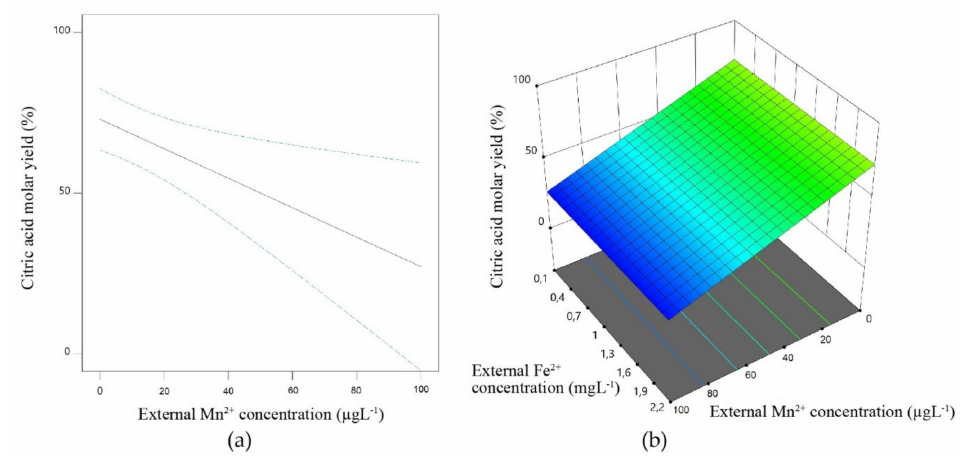
Figure 1. Response surface-based demonstration of the relationship between citric acid molar yield and the external concentration of metal ions. Input data are taken from well-documented, publicly available fermentations [4,6,45–49]. Plots were made with Design Expert 11 (Stat-Ease Inc., Minneapolis, MN, USA). ( a ) 2D plot showing the effect of external Mn 2+ ion concentration on citric acid molar yield. Dashed lines indicate uncertainty margins. ( b ) 3D plot showing the interaction effects of external Mn 2+ and Fe 2+ ions on citric acid molar